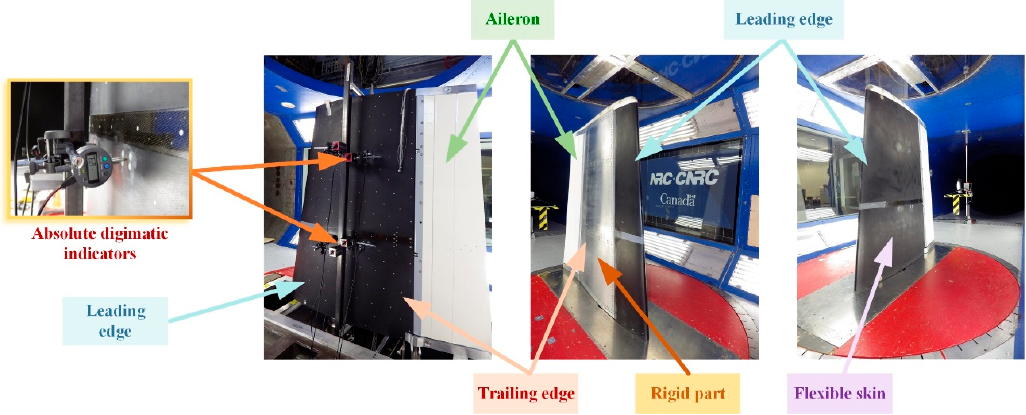
Figure 16. Morphing wing-aileron experimental model in the Institute for Aerospace Research of the National Research Council Canada (IAR-NRC) wind tunnel testing room.